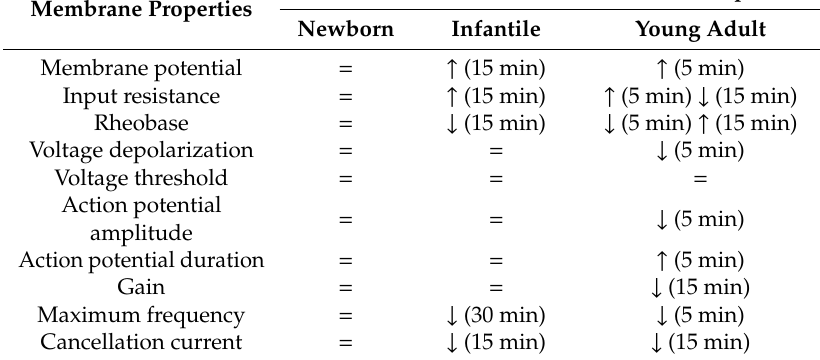
Table indicates the alterations found ( ↑ : increase, ↓ : decrease, and = : no alteration) and the minimum time of incubation with CH required to observe the